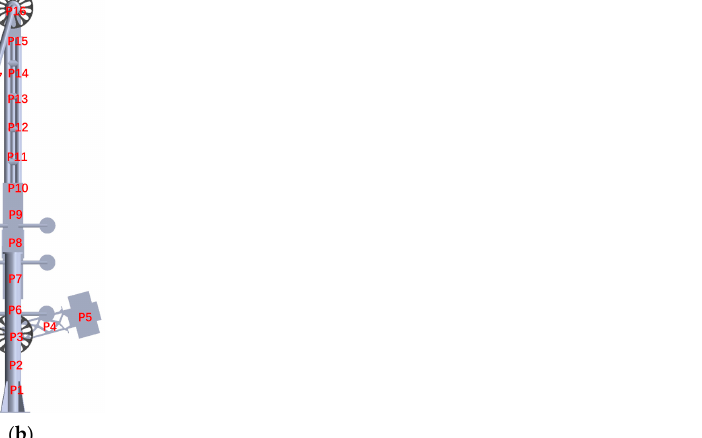
Figure 20. Detection and analysis of the position distribution of the LNG marine loading arm. ( a ) Structure before improvement; ( b ) structure after improvement.